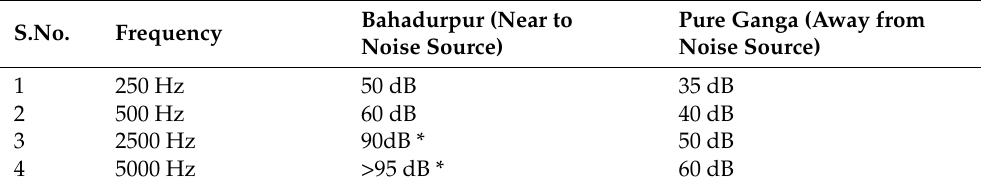
Table 4. The minimum audible noise level for Bahadurpur and Pure Ganga study was determined through an audiometric test (the average of responses for most responders are